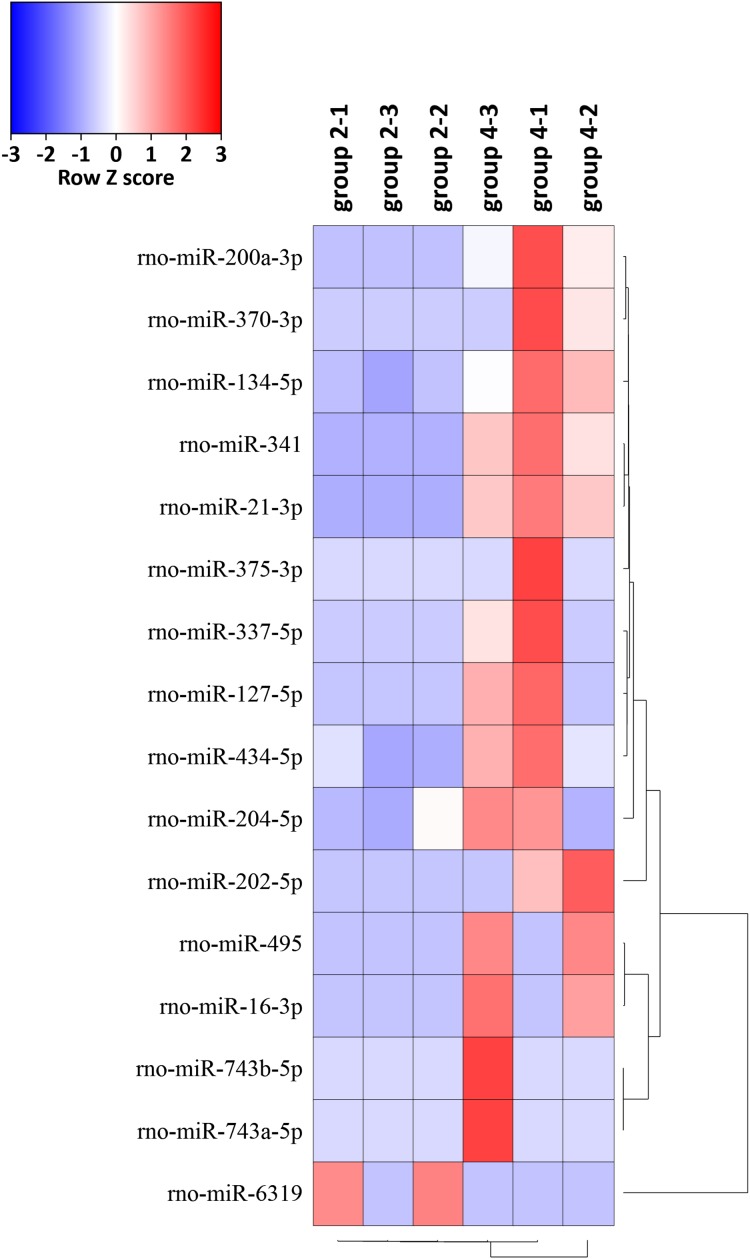
Hierarchical cluster analysis of 16 DEMs related to the preventive effects of ART on mechanical VA in response to LV afterload increases based on expressions of six tissue samples in groups 2 and 4.Red represents increased miRNA expression and blue represents reduced miRNA expression. MiRNAs limited to |log2(foldchange)| > 1 and p < 0.05 were displayed in the heat map. DEMs, differentially expressed miRNAs.